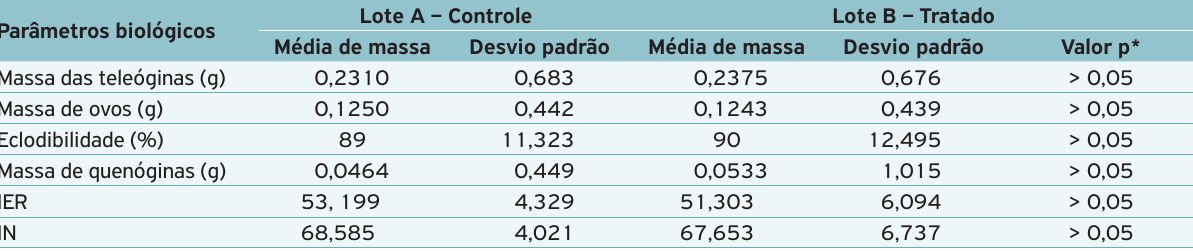
Tabela 1. Parâmetros biológicos de fêmeas ingurgitadas de R . ( B .) microplus em bovinos sem a utilização de isopatia (Lote A)